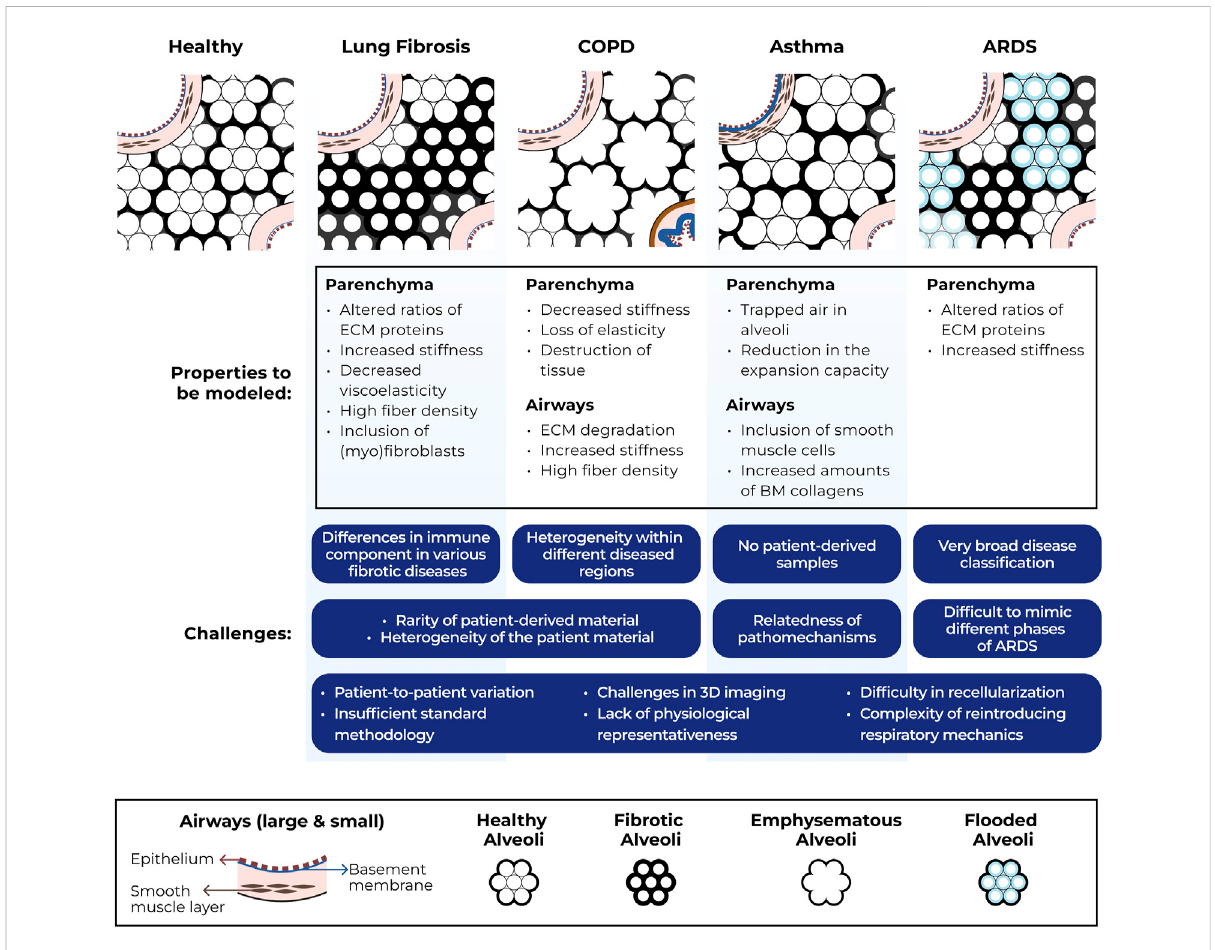
FIGURE 1 Schematic representation of structural ECM changes in lung diseases, ideal properties for modeling immune cell migration through ECM in these disease conditions and challenges associated with generating such models. COPD = chronic obstructive pulmonary disease, ARDS = acute respiratory distress syndrome, ECM = extracellular matrix, BM = basement membrane, 3D =